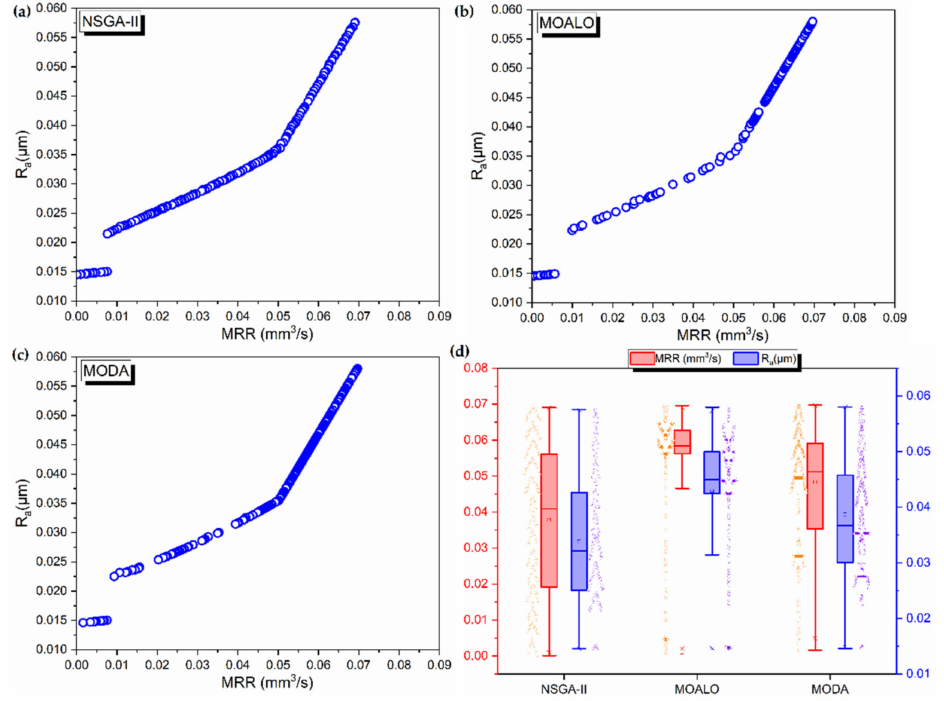
Figure 2. Pareto fronts for optimization of micro-turning process using ( a ) NSGA-II ( b ) MOALO ( c ) MODA. ( d ) Box plot showing the spread of the Pareto